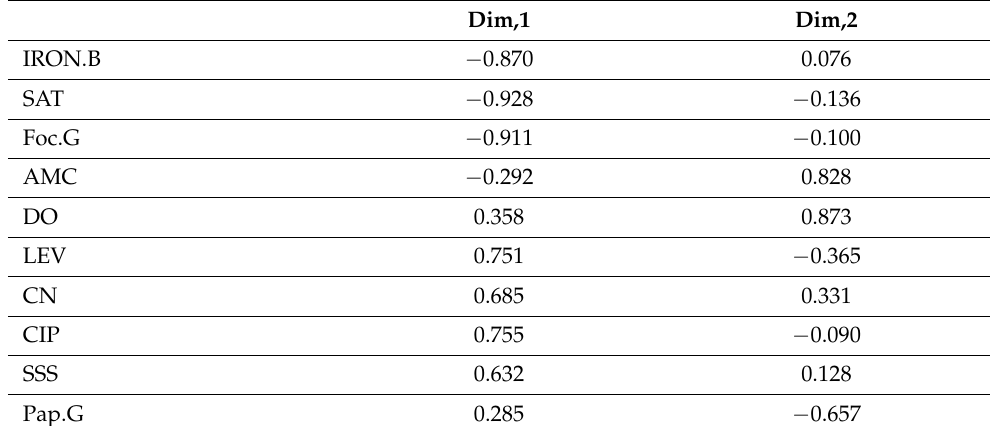
Table 6. Correlation between the starting variables and the principal components.